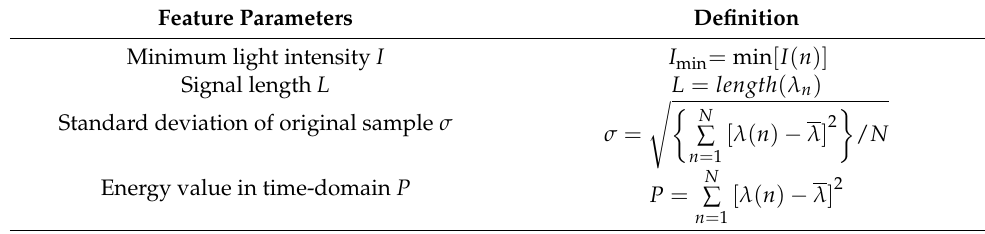
Table 2. Definitions of four feature parameters.